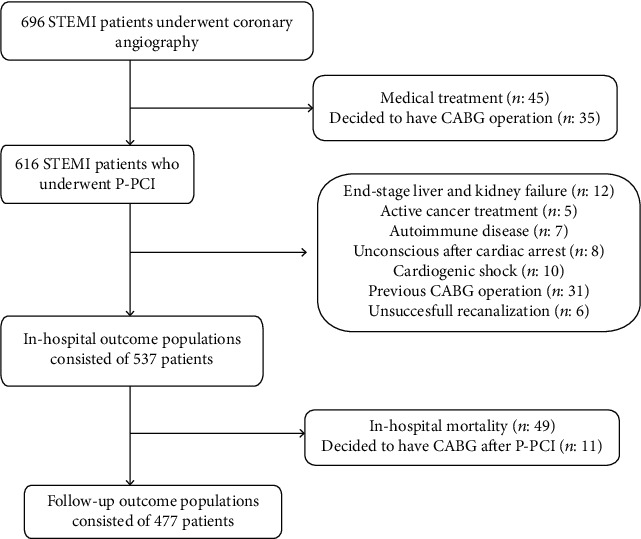
Flow diagram demonstrating enrollment and follow-up study patients.